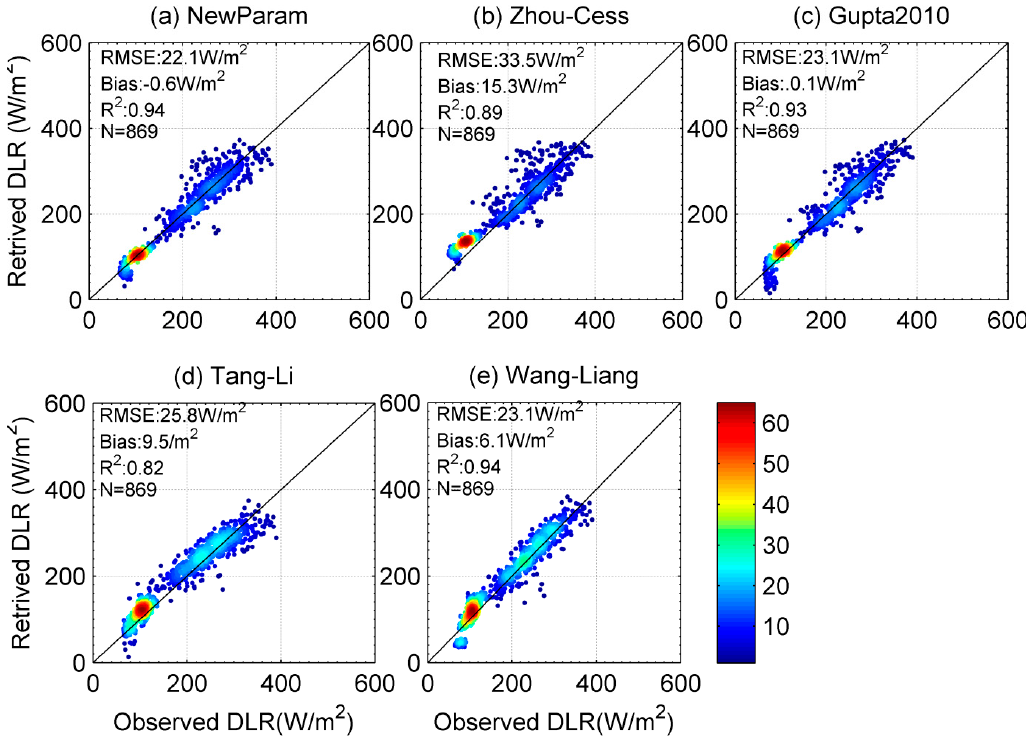
Remote Sens. 2019 , 11 FOR PEER REVIEW Figure 10. Same as Figure 9 but for the sites in the arid regions. Figures ( a ) to ( e ) represent the results from NewParam, Tang-Li, Wang-Liang, Zhou-Cess, and Gupta2010 algorithms.